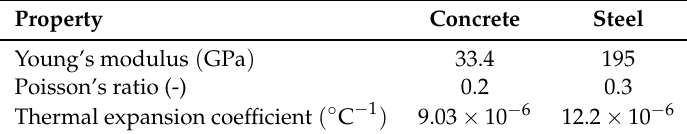
Table 5. Mechanical properties of concrete and steel at room temperature.